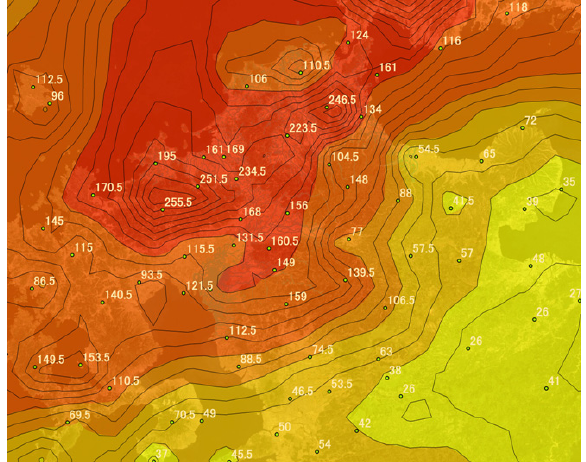
Figure 13. Expansion of Figure 11 in heavy rain district (In 48